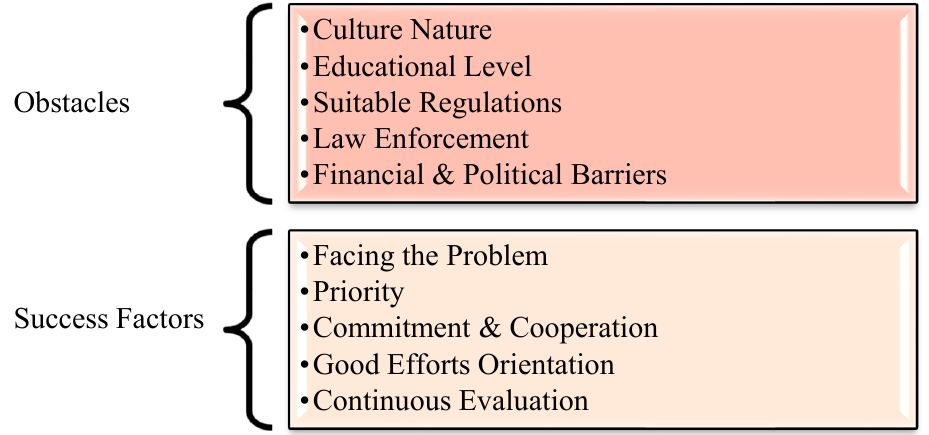
Figure 4. The obstacles and influences in the OSH development process.